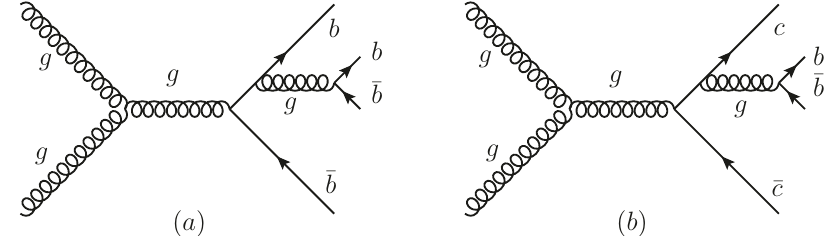
Figure 10 . Upper limit on (cid:27) ( pp channel with cut-based analysis. The solid (dashed) lines show the 2 (cid:27) -5 (cid:27) band on taking 0% (5%) systematic uncertainties.